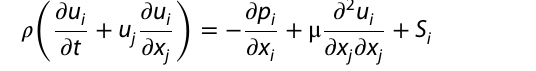
Fig. 4 Schematic diagram of the boundary conditions applied to the